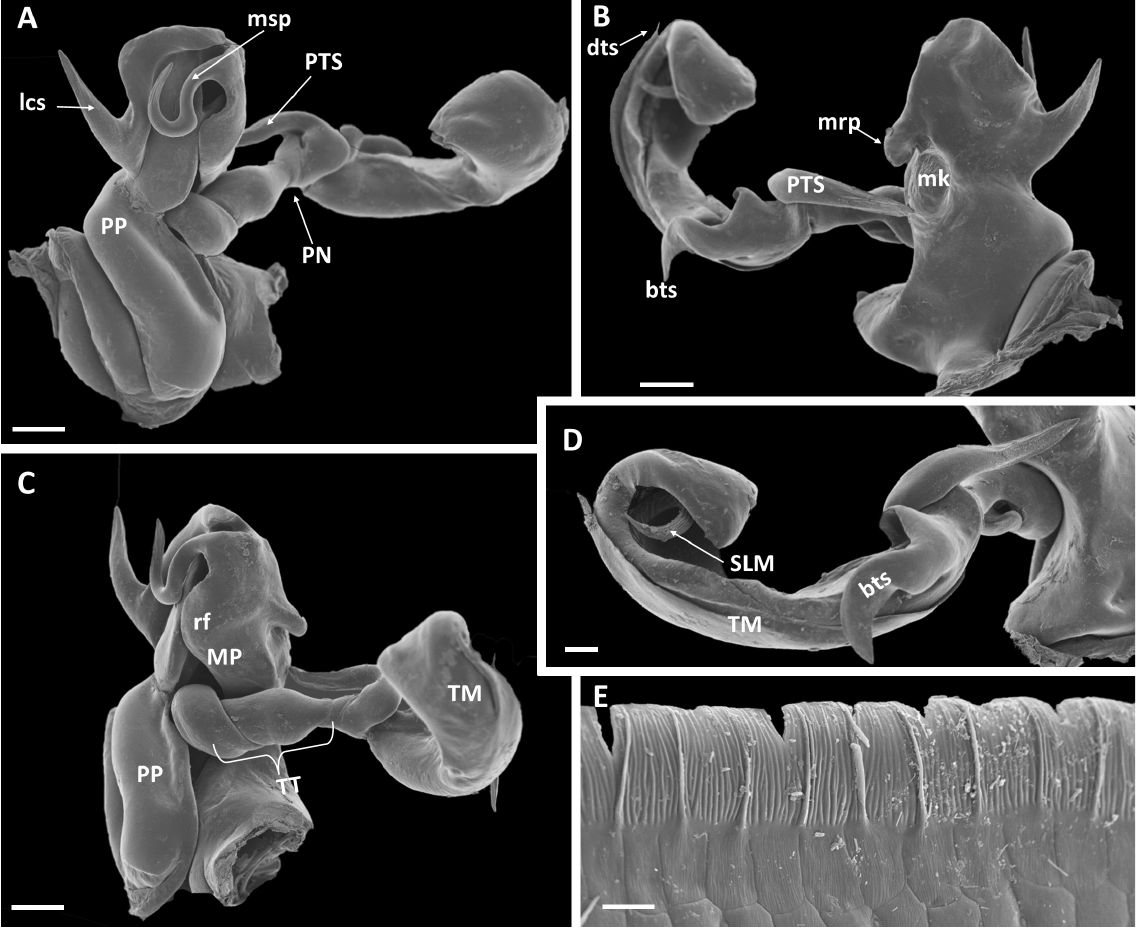
Fig. 8. Antipustia hoteldolichoiuli gen. et sp. nov., holotype, ♂ (NHMD 621699). A–D . Left